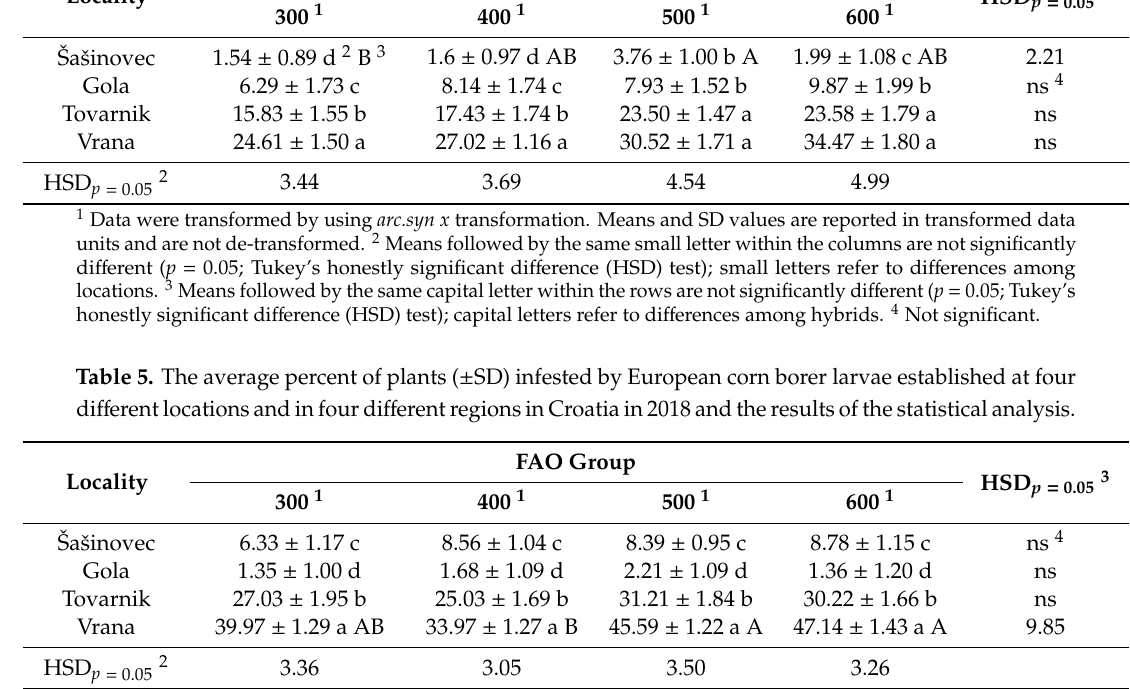
Table 4. The average percent of plants ( ± SD) infested by European Corn Borer larvae established at four di ff erent locations and in four di ff erent regions in Croatia in 2017 and the results of the statistical analysis. Locality